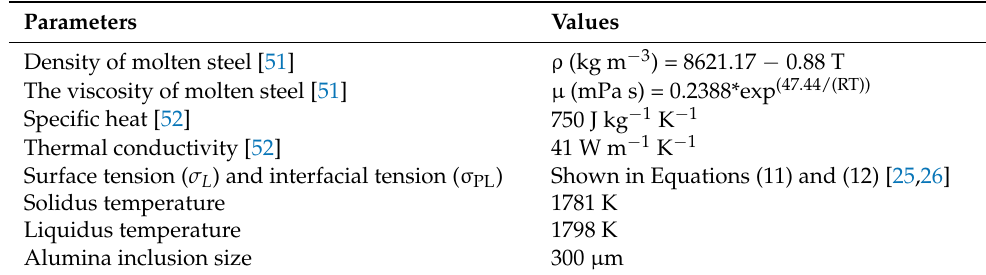
Table 2. Thermophysical properties of SPFH590 steel.